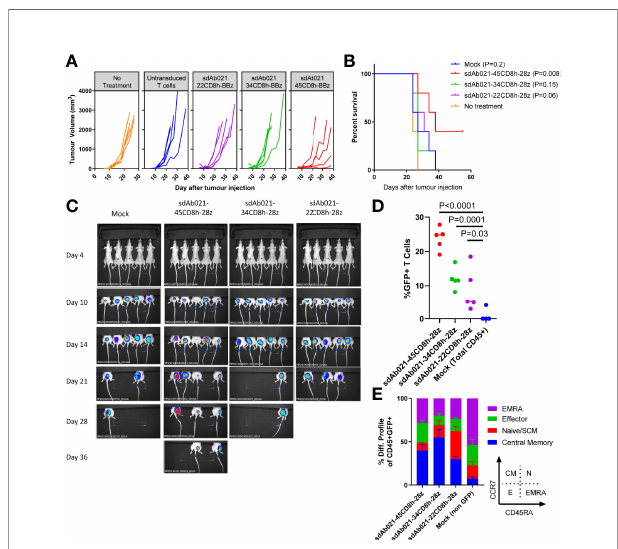
FIGURE 8 | Hinge truncation results in similar progressively diminished EGFR- speci fi c sdCAR response to human glioblastoma xenografts in vivo . (A) NSG mice were injected (N= 5 mice/group) subcutaneously with 1×10 6 U87vIII cells stably expressing mKate2. At 7 and 14 days post-tumor challenge mice were injected intratumorally with 1×10 7 total T cells (approx. 2.5×10 6 hinge-modi fi ed sdCAR-T cells) or with untransduced control T cells (mock). Tumor growth was monitored via caliper measurements. N=5 mice per group. (B) Mice were sacri fi ced at pre- determined endpoints based on animal condition or tumor volume >2000 mm 3 . P values are derived from Mantel-Cox test of survival curves in comparison with untreated mice. (C) In vivo imaging was performed to examine the mKate2 fl uorescent signal associated with tumor cells. (D) Blood was drawn from challenged mice and examined for the proportion of sdCAR-transduced cells (GFP +) within the hCD45+ lymphocyte fraction at the fi nal timepoint where all experimental mice were alive (day 21). (E) sdCAR-T cells, or total hCD45+ cells for mock T cell treated mice, were examined for differentiation status using antibody staining for human CCR7 and CD45RA. See inset for gating strategy used to delineate effector, naïve/SCM, central memory, or effector memory-RA+ (EMRA)